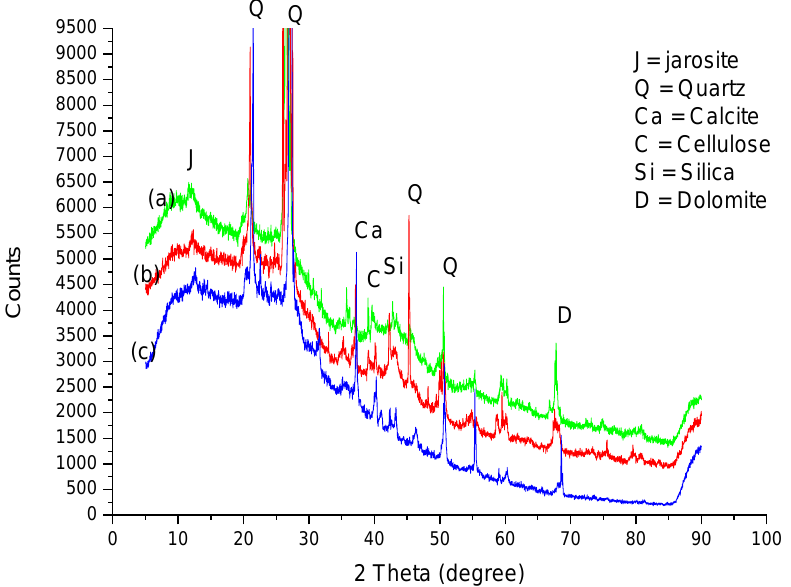
Figure 8. (A–C) XRD patterns of substrate: treatment (A), control (B), and initial substrate